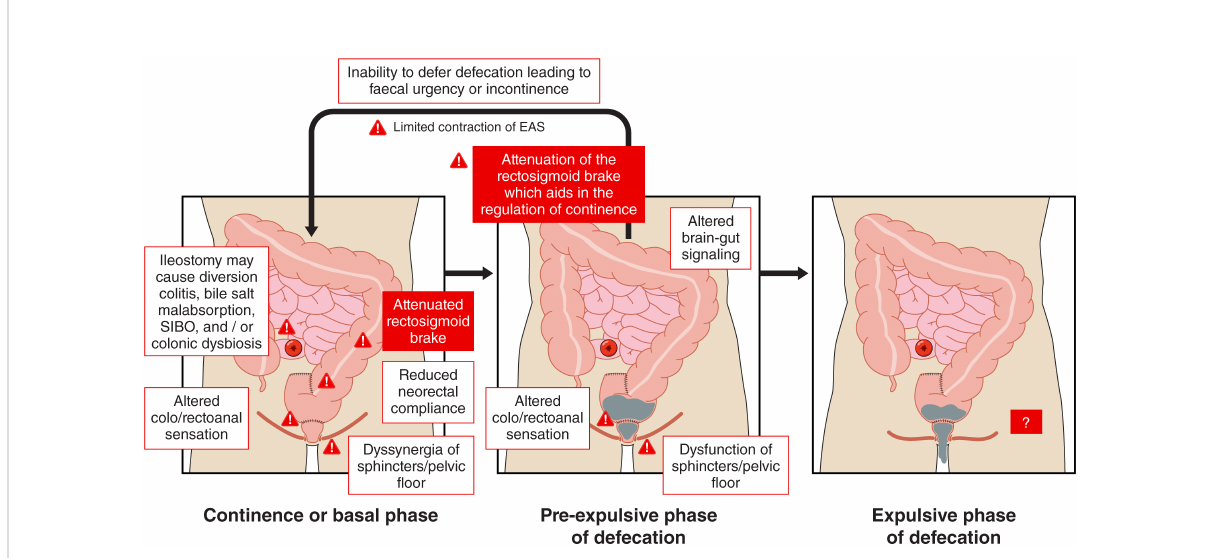
FIGURE 2 Putative mechanisms contributing to low anterior resection syndrome during the basal, pre-expulsive, and expulsive phases. Mediators of injury arising from surgery, radiotherapy, and ileostomies (as described in Figure 5) are described in this fi gure. Diverting ileostomies may cause diversion colitis, bile salt malabsorption, small intestinal bacterial overgrowth (SIBO), and/or colonic dysbiosis. Similarly, changes in colo/ rectoanal sensation, neorectal compliance, sphincter, and pelvic fl oor dyssynergia, altered distal colonic motility, and limited external anal sphincter (EAS) function also contribute. Little is known about the pathophysiological mechanisms for low anterior resection syndrome during the expulsive phase of defecation and more research is required in this